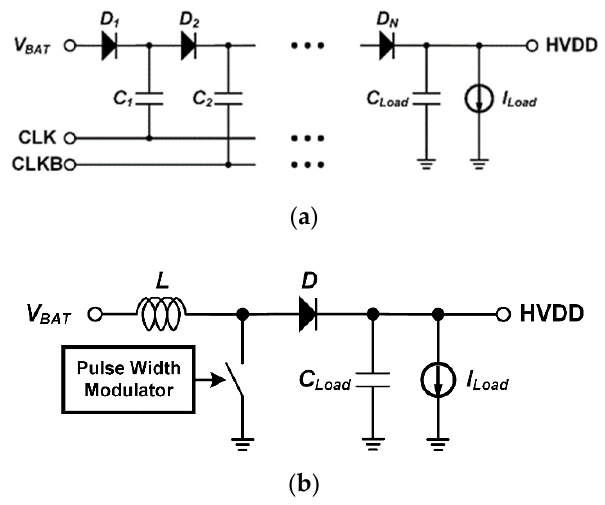
Figure 3. Conventional step-up converters: ( a ) Dickson charge pump; ( b ) inductive boost converter.